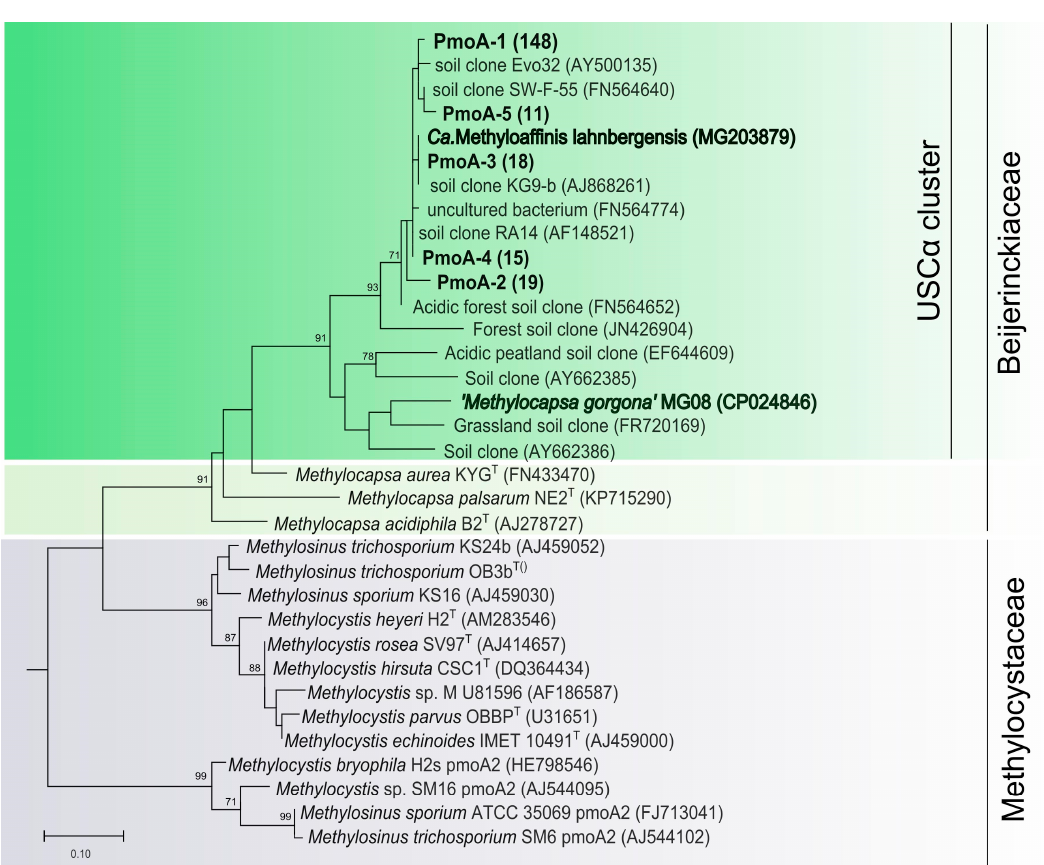
Figure 2 . Phylogenetic tree constructed based on 201 amino acid sites of partial PmoA sequences obtained from a forested tundra soil (shown in bold), as well as PmoA from representative members of the families Beijerinckiaceae and Methylocystaceae and some environmental clone sequences. The scale bar corresponds to 0.1 substitutions per amino acid position.